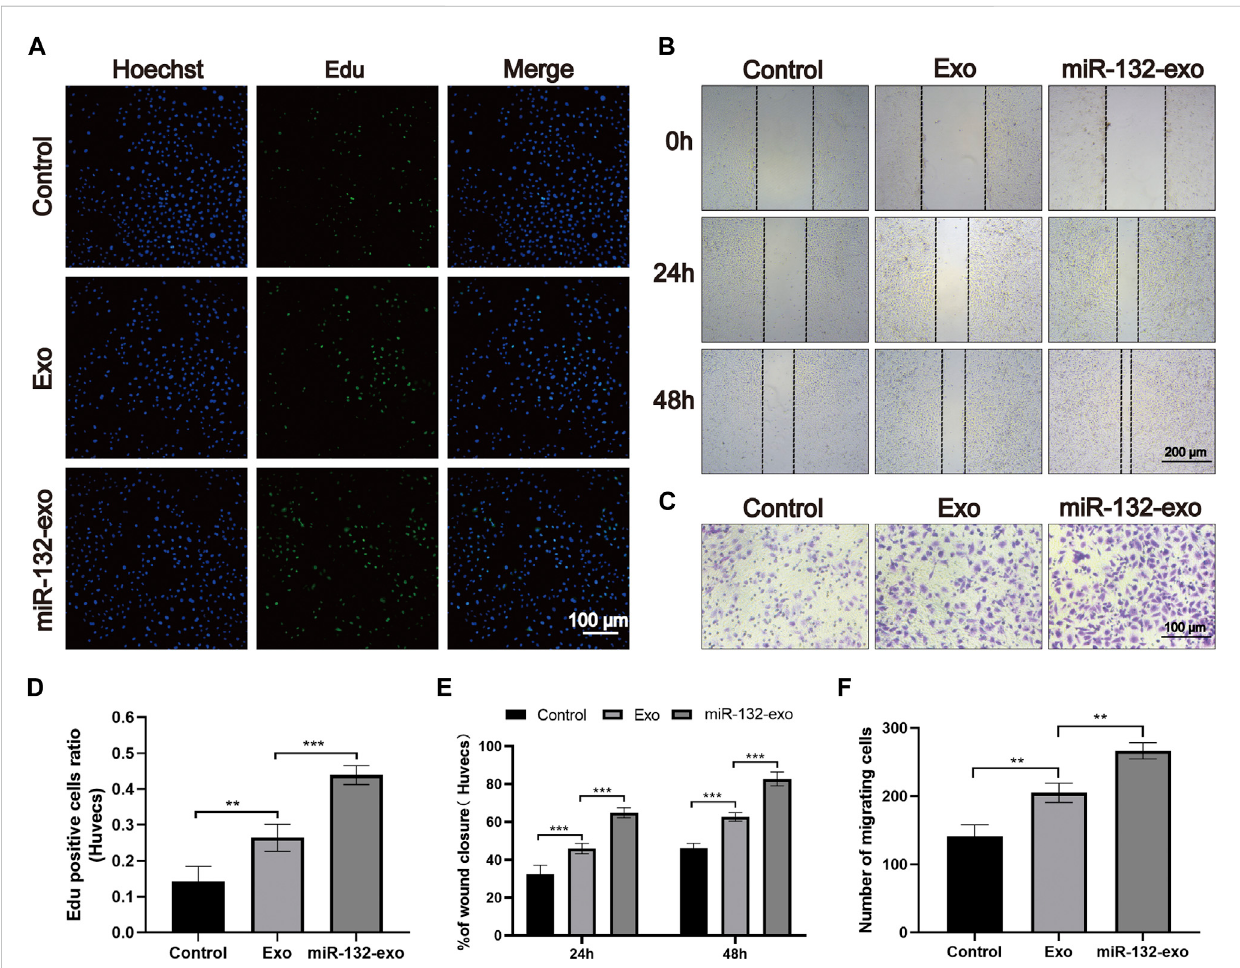
FIGURE 2 TheeffectofmiR-132-exoontheproliferationandmigrationofHUVECs invitro . (A) Representative fl uorescenceimagesofEdUstainingofHUVECs treated with PBS, exosomes, and miR-132-exo for 24 h (scale bar = 100 μ m); (B) Scratch wound assay of HUVECs following treatment with PBS, exosomes, and miR-132-exo at 0, 24 and 48 h (scale bar = 200 μ m); (C) Representative transwell migration assay images of HUVECs treated with PBS, exosomes, and miR-132-exo for 12 h (scale bar = 100 μ m); (D) Quantitative analysis of the EdU staining for proliferation rates in each group; (E) Quantitative data of the percentage of scratch wound closure in each group; (F) Quantitative analysis of the migrated cells HUVECs in each group. * p